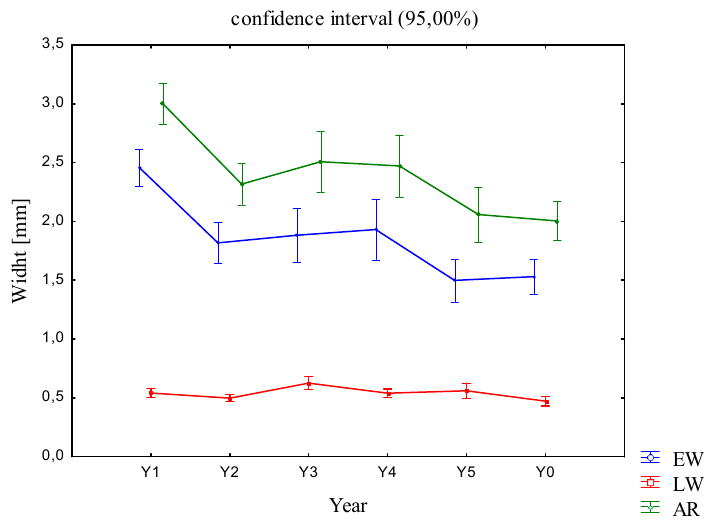
Figure 7. Mean width of annual rings in comparable tree groups (EW—early wood; LW—latewood; AR—annual ring).